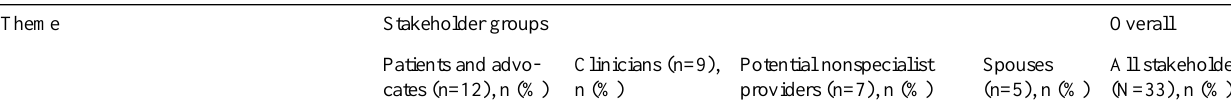
Table 4. Integrating and sustaining nonspecialist providers within the existing health care system.